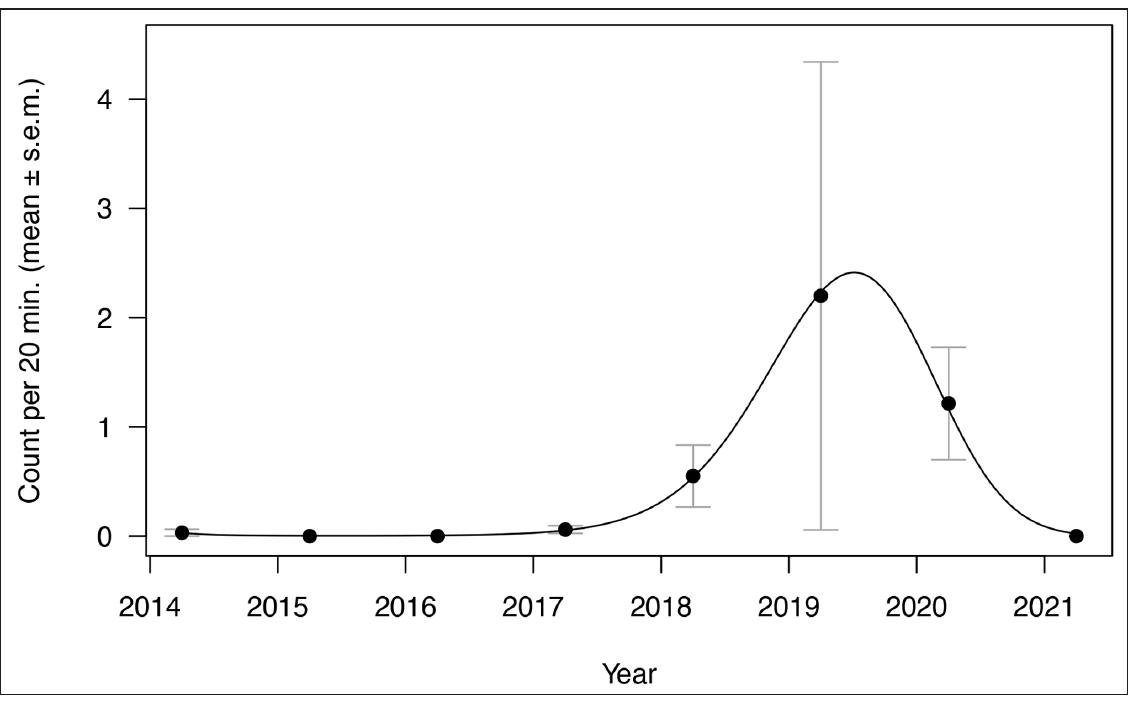
Figure 3 The abundance of the New Zealand (NZ) blue, Zizina oxleyi , on Lincoln Universitys campus since 2014, as revealed by student 20-minute butterfly counts. These were entered into an iNaturalist project that included observation fields for the maximum and minimum counts; the time surveying, in minutes; and whether or not the observer searched for all butterflies. The increase in butterflies corresponded with the clearance of a large building, which created a 2-hectare wild area from late 2017 to the end of 2020. The fitted line is from a quadratic quasipoisson generalized linear